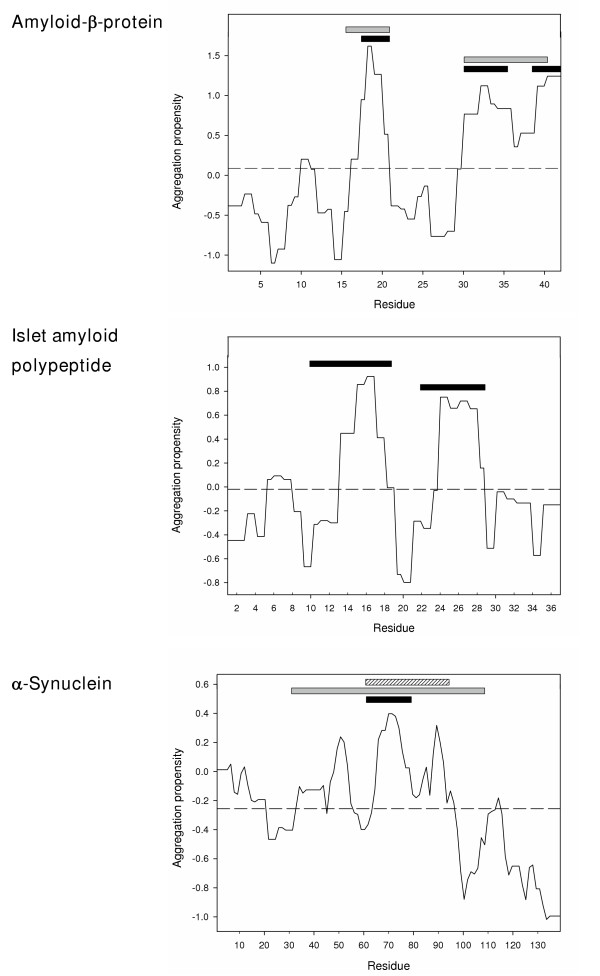
Aggregation profile of natively unfolded proteins related to disease. The average aggregation propensity of the different polypeptides is shown as a dashed line. Minimal protein regions which have been experimentally proven to be involved in aggregation are shown at the top of the plot as black bars. Regions in the core of the fibrils are shown as grey bars (when information available). The NAC fragment of α-Synuclein is shown as a dashed bar.